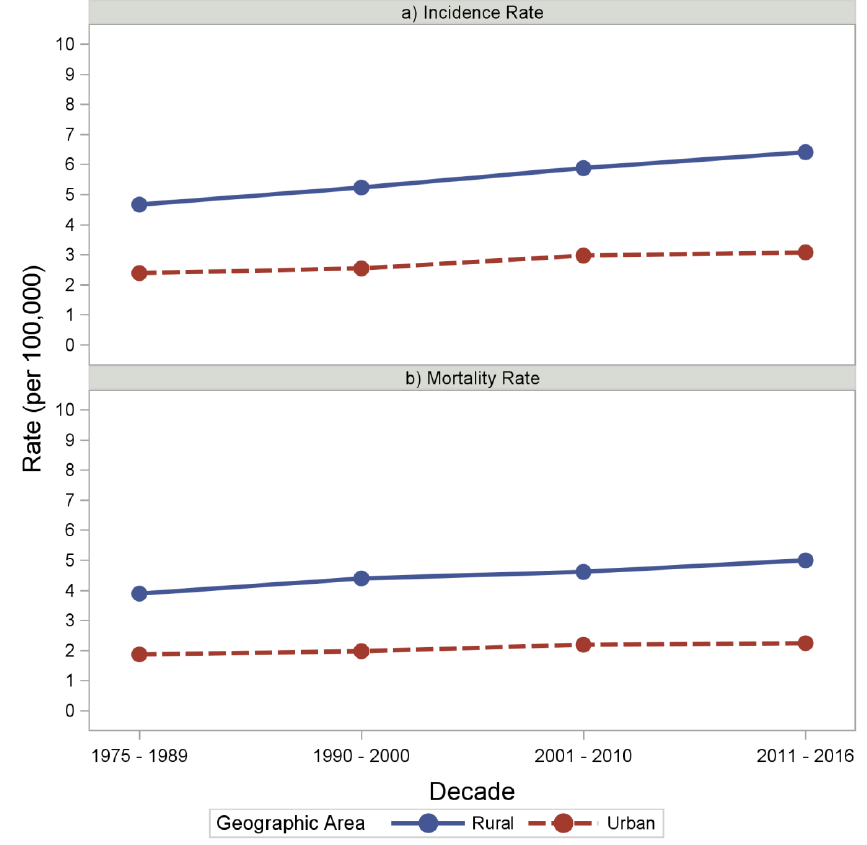
Figure 1. Incidence and Mortality trends of esophageal cancer between 1975 and 2016. ( a ) The trends of incidence rates per 100,000 population in rural and urban areas between 1975 and 2016. ( b ) The trends of mortality rates per 100,000 patients in rural and urban areas between 1975 and 2016. In addition to comparing the trends between rural and urban populations, we per- formed attributable risk percentage and population attributable risk percent calculations Table 2. Univariate cox proportional modeling for OS and DSS in the SEER between these two populations. The attributable risk percentage and the population at- tributable risk percent for esophageal cancer incidence ranged from 30.20 to 61.90 and from 1.39 to 6.98 between 1975 and 2016, respectively. The table with attributable risk percentage and population attributable risk for every year between 1975 and 2016 is pre- sented in supplementary material as Table S3.